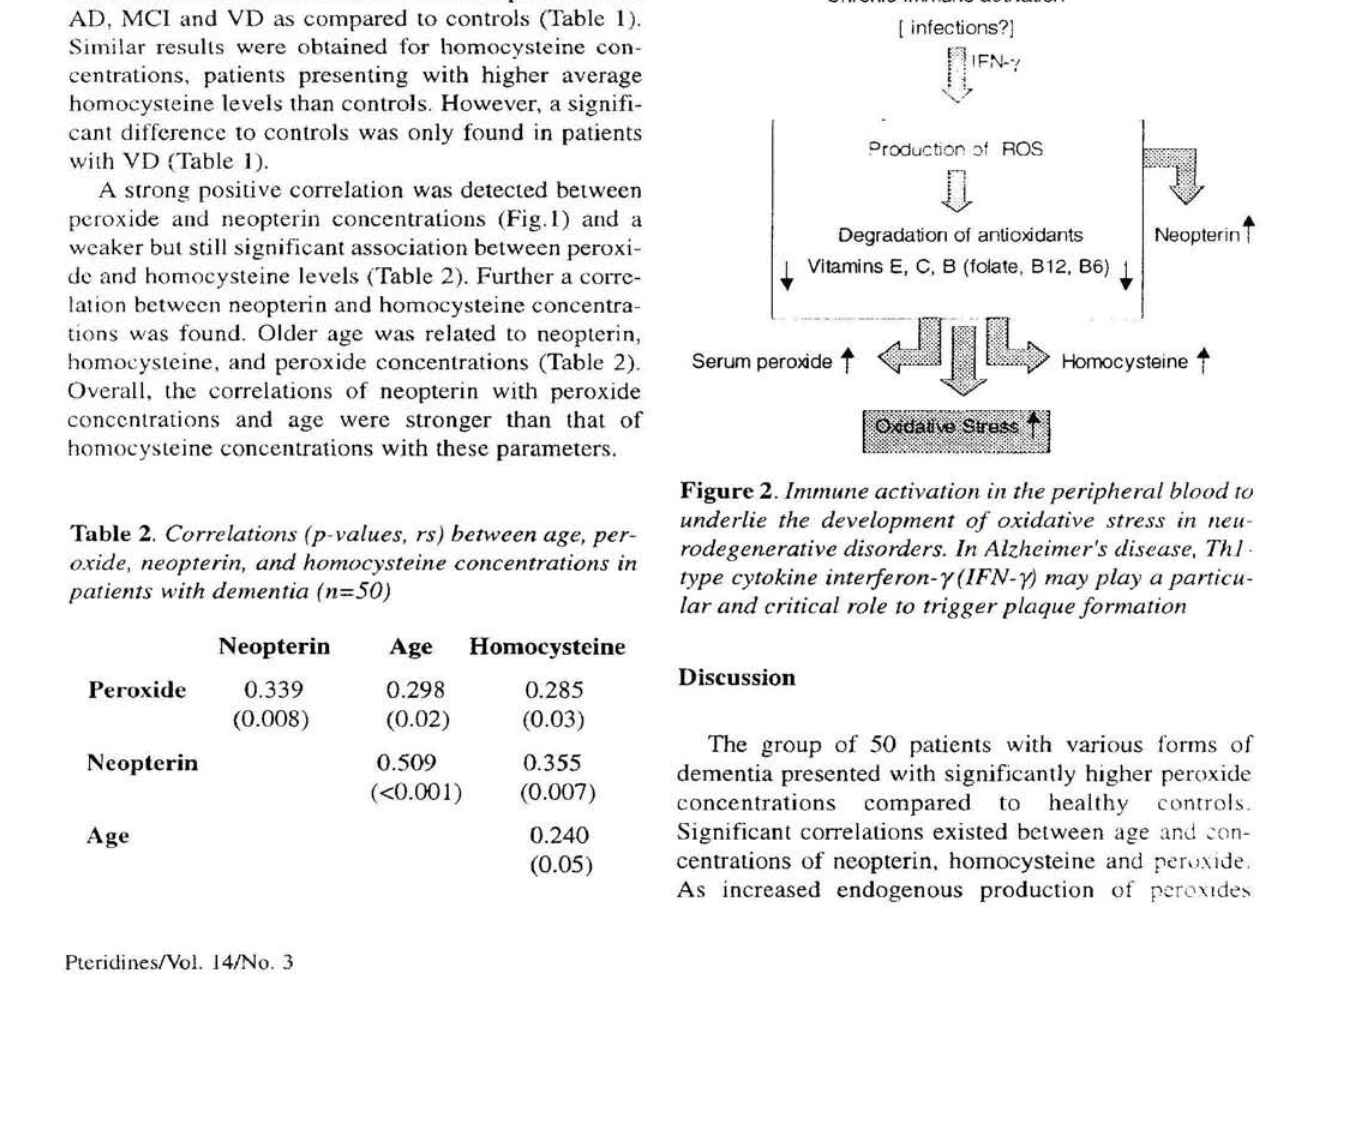
Figure 1. Serum concentrations of neopterin and peroxides in 50 patients with various forms of dementia (note log-scale of neopterin concentrations)